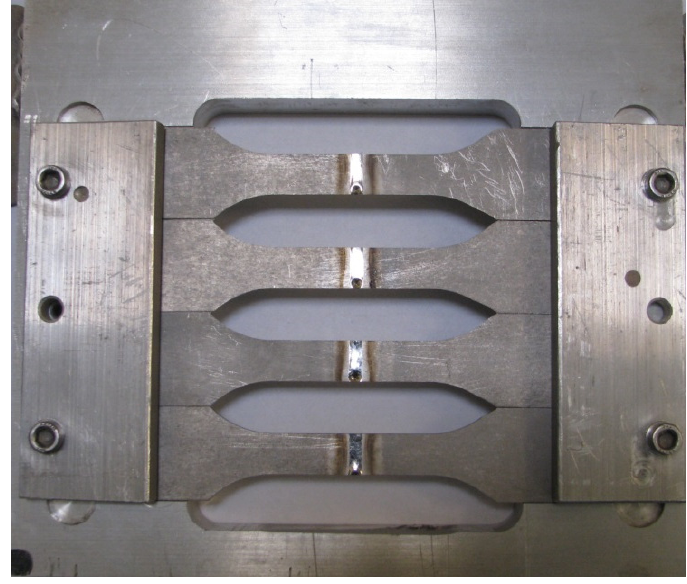
Figure 3. Butt welded test samples (type 2) fixed positioning device.